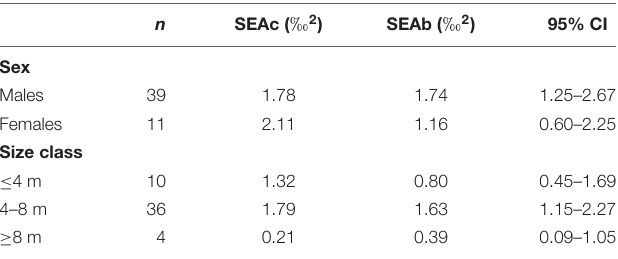
TABLE 3 | Isotopic niche area estimates and parameters of whale shark dermis separated by sex and size class.